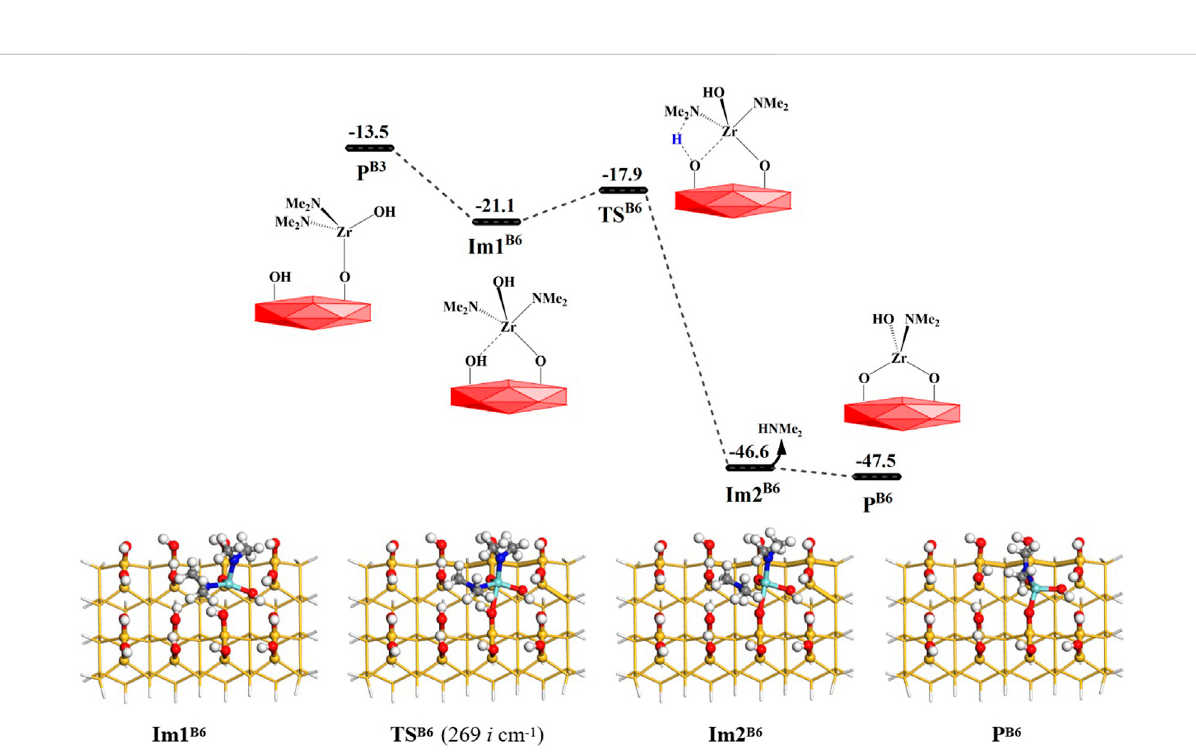
FIGURE 10 Gibbs free energy ( Δ G , kcal/mol) pro fi les of the B6 section of the H 2 O reaction with the aminated surface.